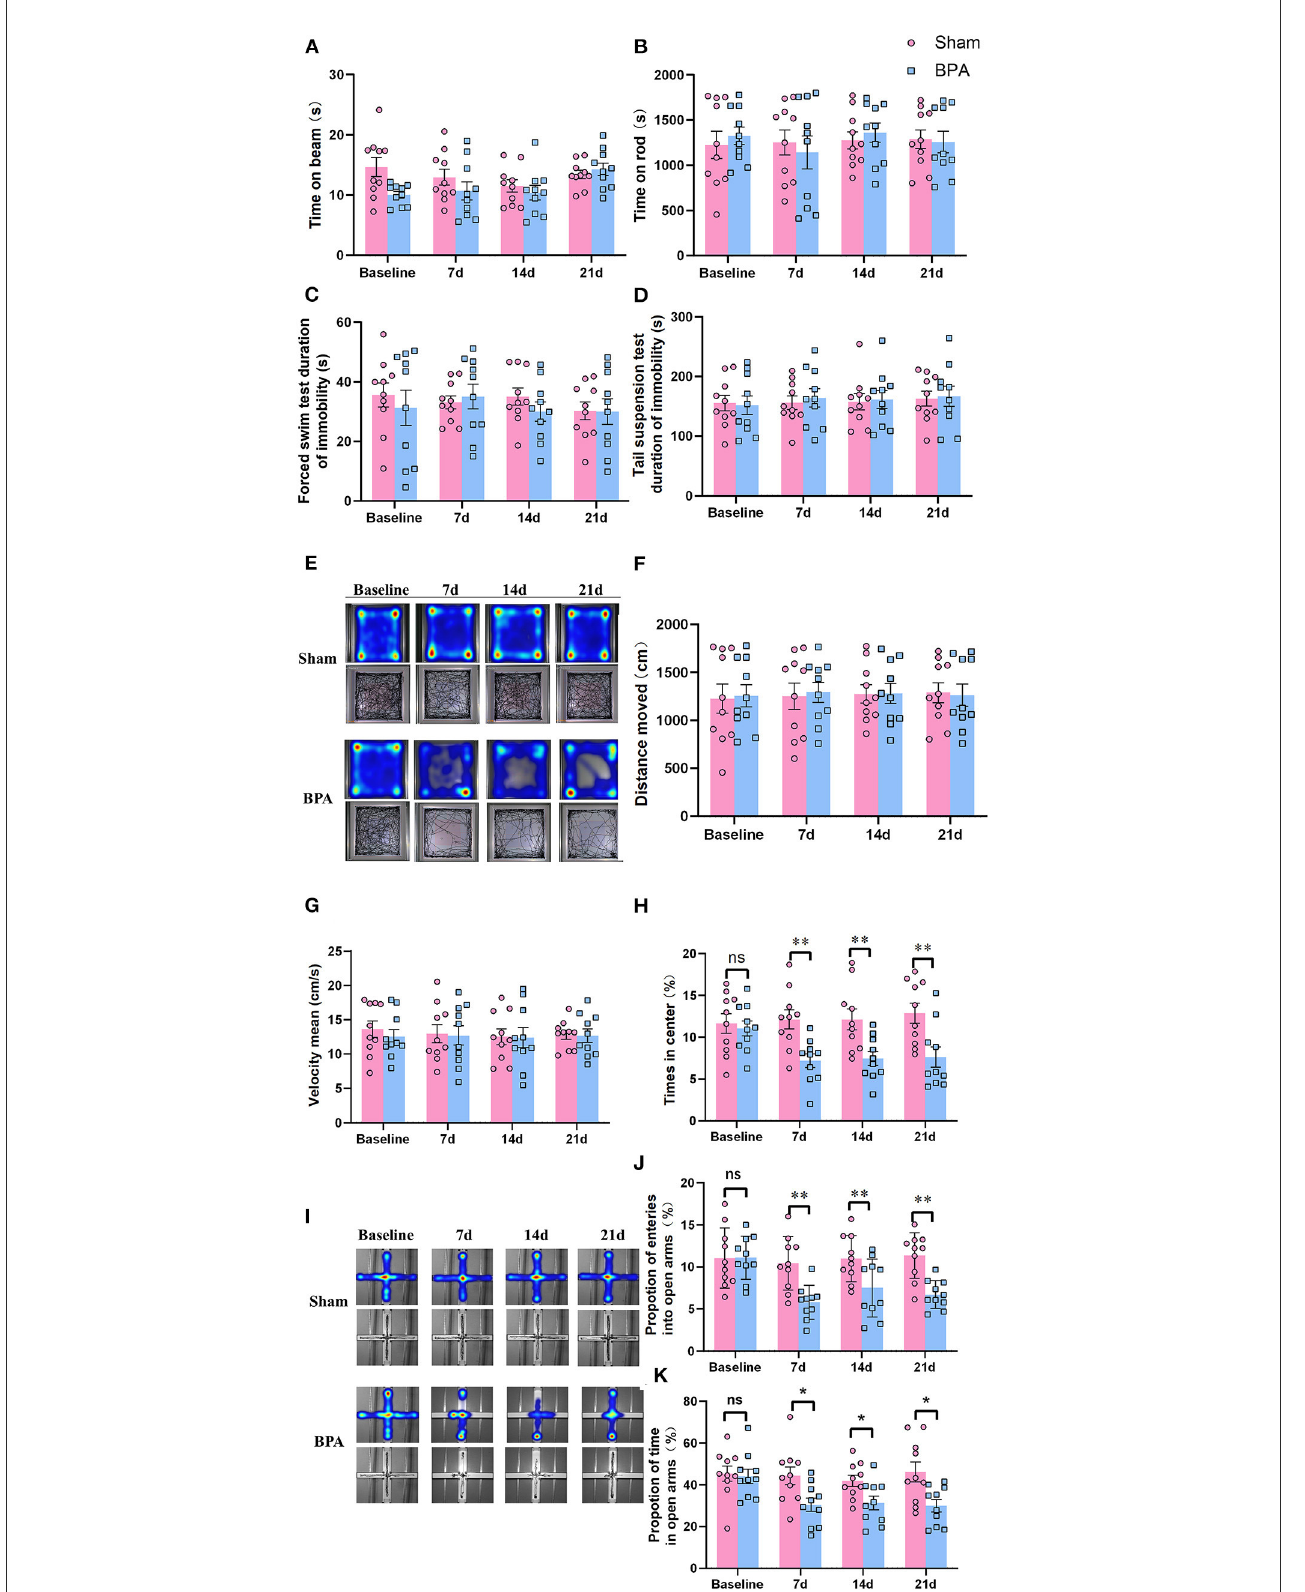
FIGURE2 Detection of depression and anxiety-like behaviors in BPA mice over time. (A) BWT detection showed no difference of the time on the beam at each time point. (B) Rota-Rod test showed no difference of the time on the rod at each time point. (C) FST showed no difference of the immobility duration at each time point. (D) TST shows no difference of the immobility duration at each time point. (E) OFT trajectory diagram in the two groups over time. (F) The movement distance from OFT test between the two groups at each time point. (G) The movement speed from OFT test between the two groups at each time point. (H) The central area residence time from OFT test between the two groups at each time point. (I) EPM trajectory diagram in the two groups.